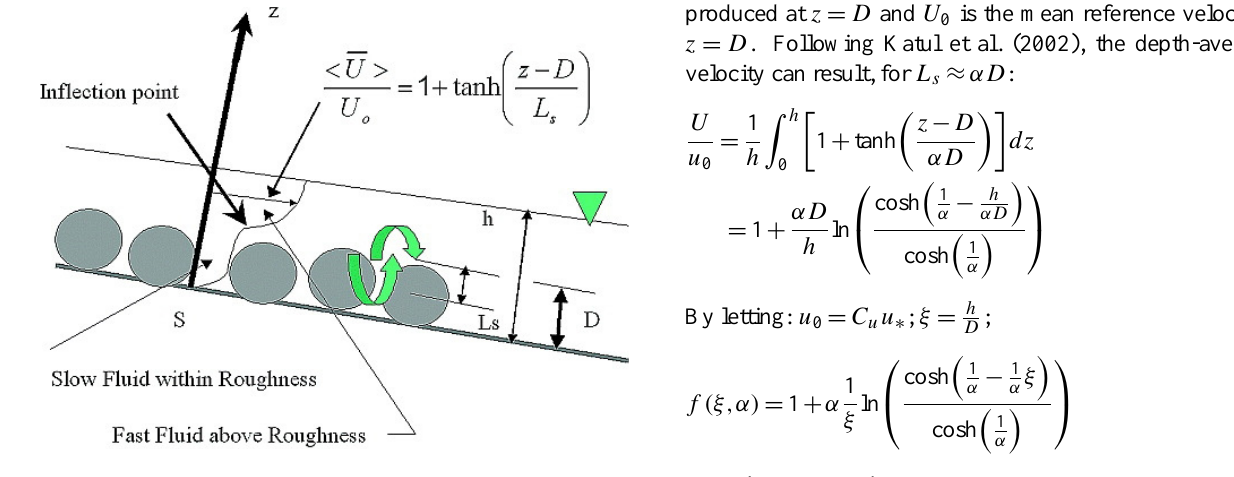
Fig. 4. Onset of free shear turbulent flows in shallow streams, after Katul et al.,